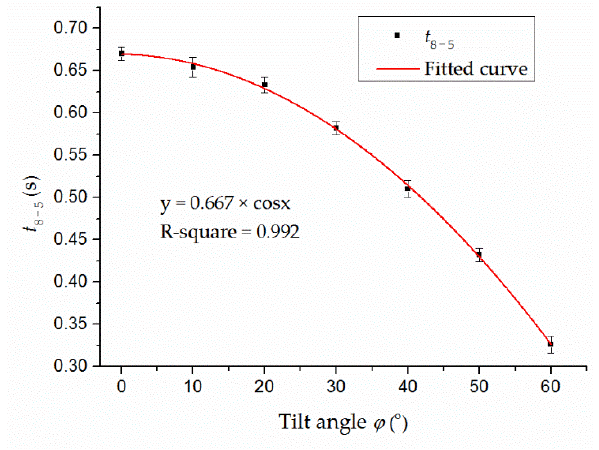
Figure 10. Influence of substrate tilt angle on t 8−5